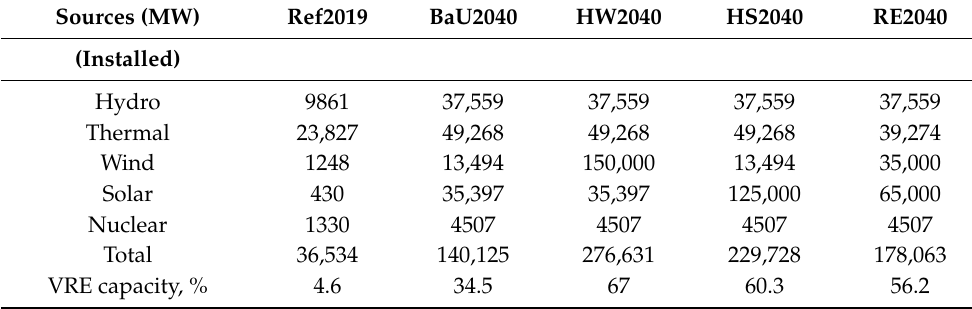
Table 4. Electricity supply sources for different scenarios in MW (installed capacities).